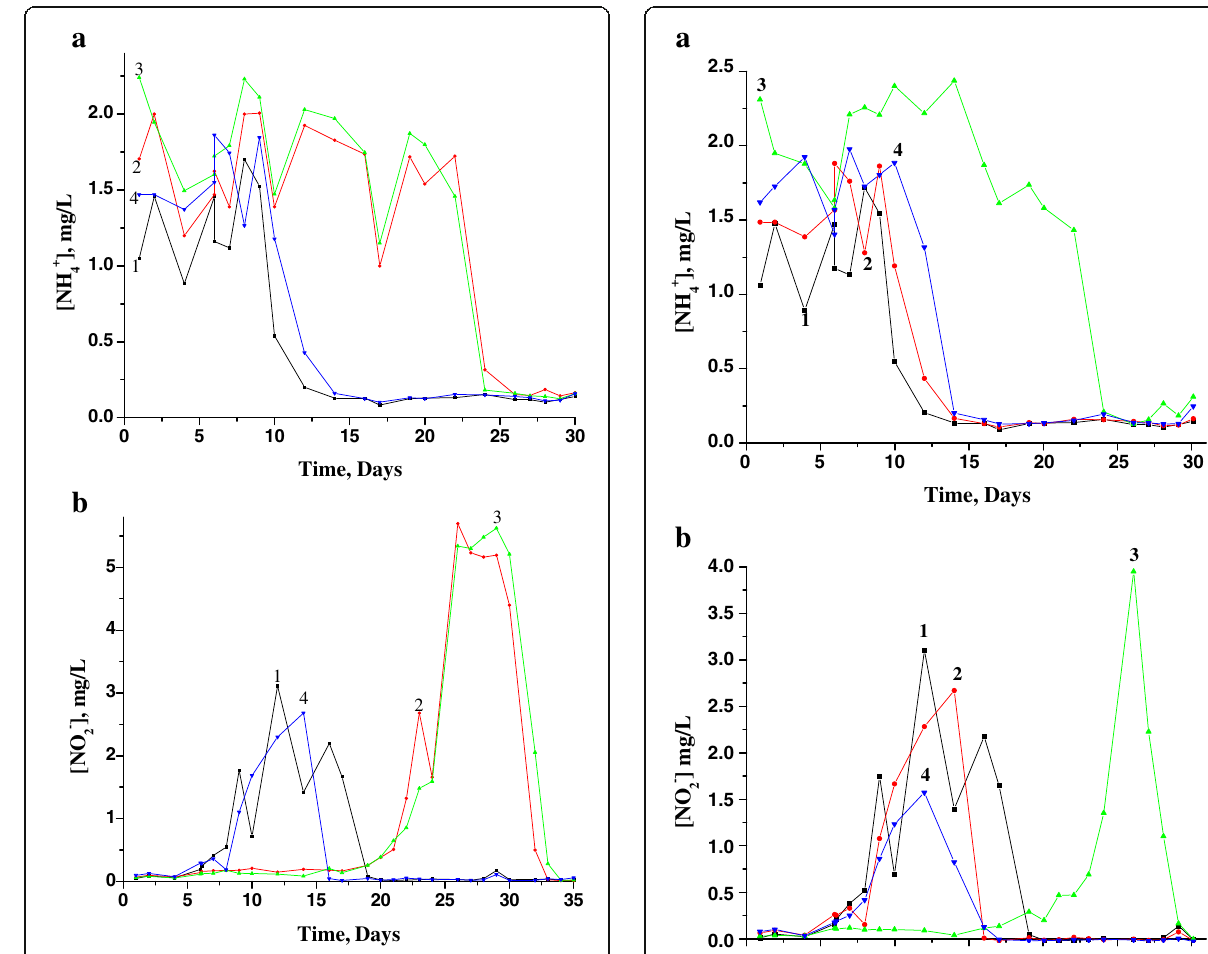
Fig. 4 Dynamics of ammonium ( a ) and nitrite ( b ) ion concentrations in the Isnovat River (October 2015) in the presence of CTMA, LS special, and their combination. 1 — Reference sample. 2 — 10 − 5 mol/L